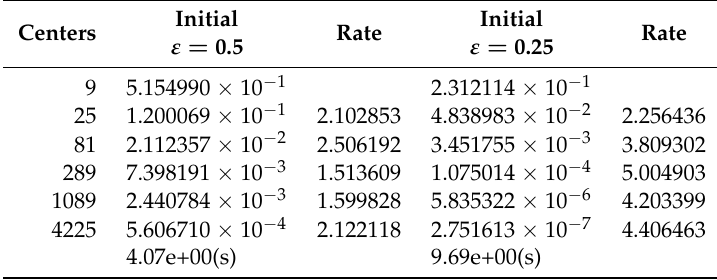
Table 9. H-RBFs collocation of example 1: with initial 0.5 and 0.25.